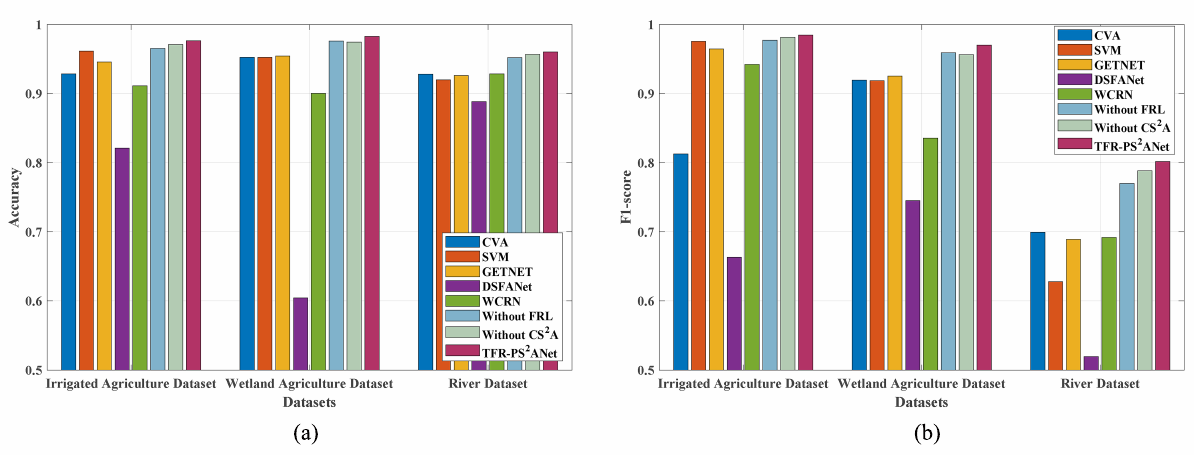
Figure 9. Overall accuracy ( a ) and F1-score ( b )